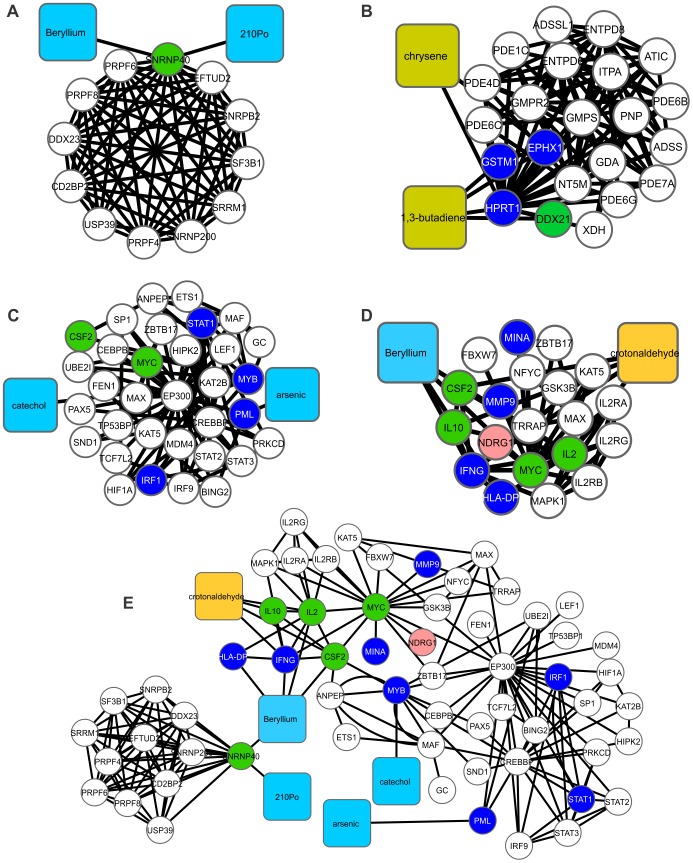
A merge of clusters 3, 6, 17 and 21.In (A), cluster 3 is composed of 14 nodes and 65 edges, with Ci = 4,643. The associated hydrophilic components are urethane, beryllium and polonium-210. Related GO terms: RNA-splicing and nucleobase, nucleoside, nucleotide and nucleic acid metabolic processes. Cluster 6 (B) is composed of 24 nodes and 102 edges, with Ci = 4,250. The associated lipophilic constituents are 1,3-butadiene and chrysene. Related GO term: nucleobase, nucleoside and nucleotide metabolic processes; cluster 17 (C) is composed of 35 nodes and 83 edges, with Ci = 2,371. The hydrophilic constituents present include catechol and arsenic. Related GO term: regulation of nucleobase, nucleoside nucleotide and nucleic acid metabolic processes. Cluster 21 (D) is composed of 22 nodes and 49 edges, with Ci = 2,227. The associated hydrophilic constituent is beryllium, and the lipophilic constituent is crotonaldehyde. Related GO term: regulation of DNA metabolic processes. The union of clusters 3, 17 and 21 (E). Cluster 6 did not show any proteins overlapping with any other cluster.